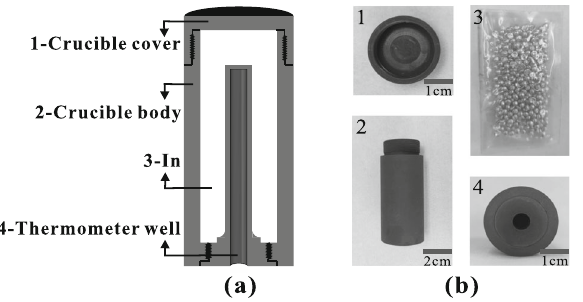
Fig. 1 a Design diagram of In phase change fixed point crucible; b 1-crucible cover; 2-crucible body; 3-metal In; 4-thermometer